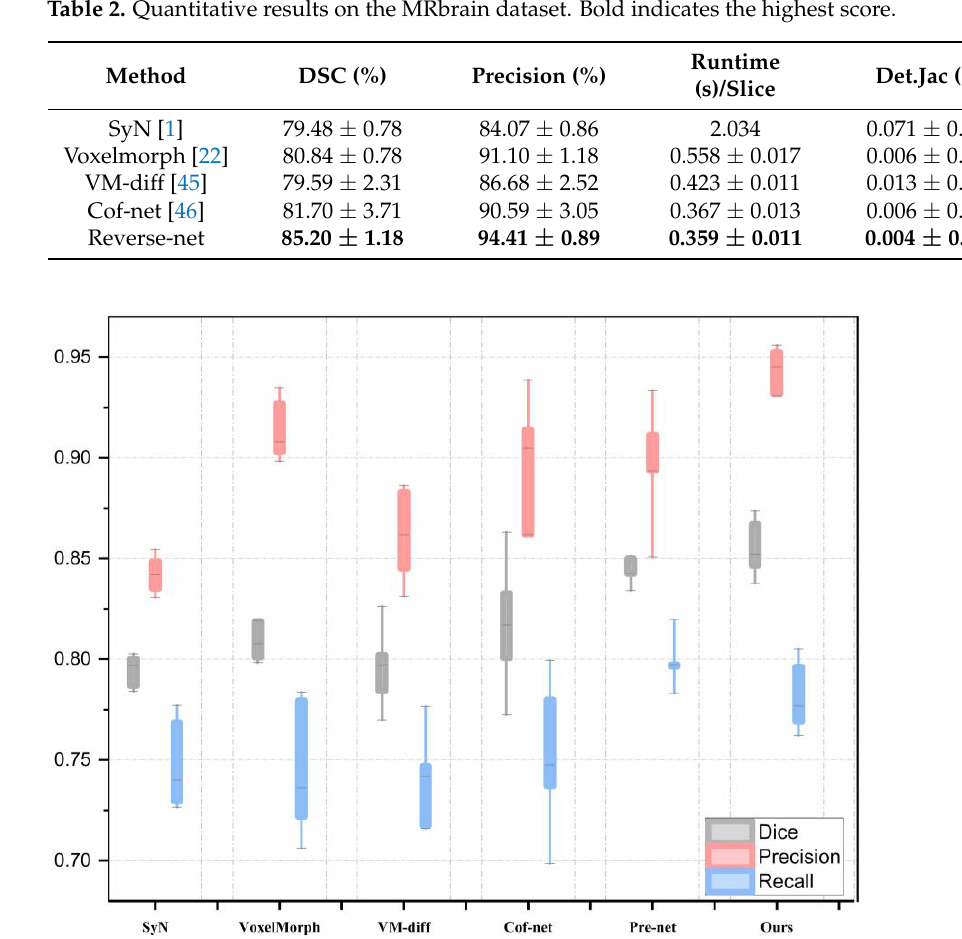
Figure 8. Registration ability of different numbers of segmented labels on the MRbrain dataset (( a – c) are the line graphs formed by the model under the three evaluation metrics of Dice, Preciaion, Recall respectively).